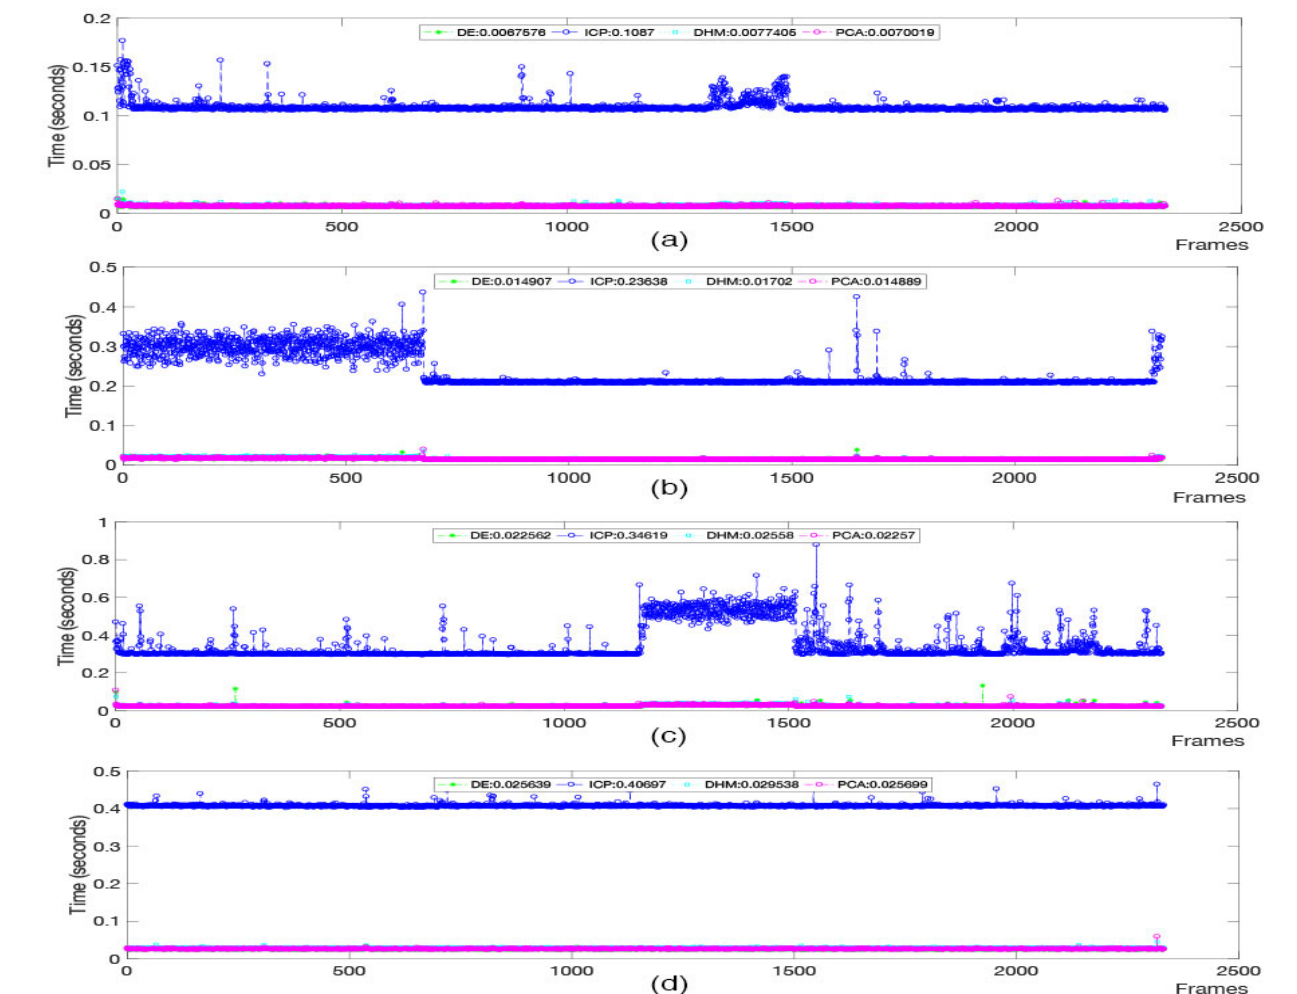
Fig. 15. Graphs showing the time spent per algorithm, frame by frame, for the amount of selected blendshapes. (a) 25 percent (21 blendshapes); (b) 50 percent (41 blendshapes); (c) 75 percent (62 blendshapes) and (d) 100 percent (80 blendshapes).